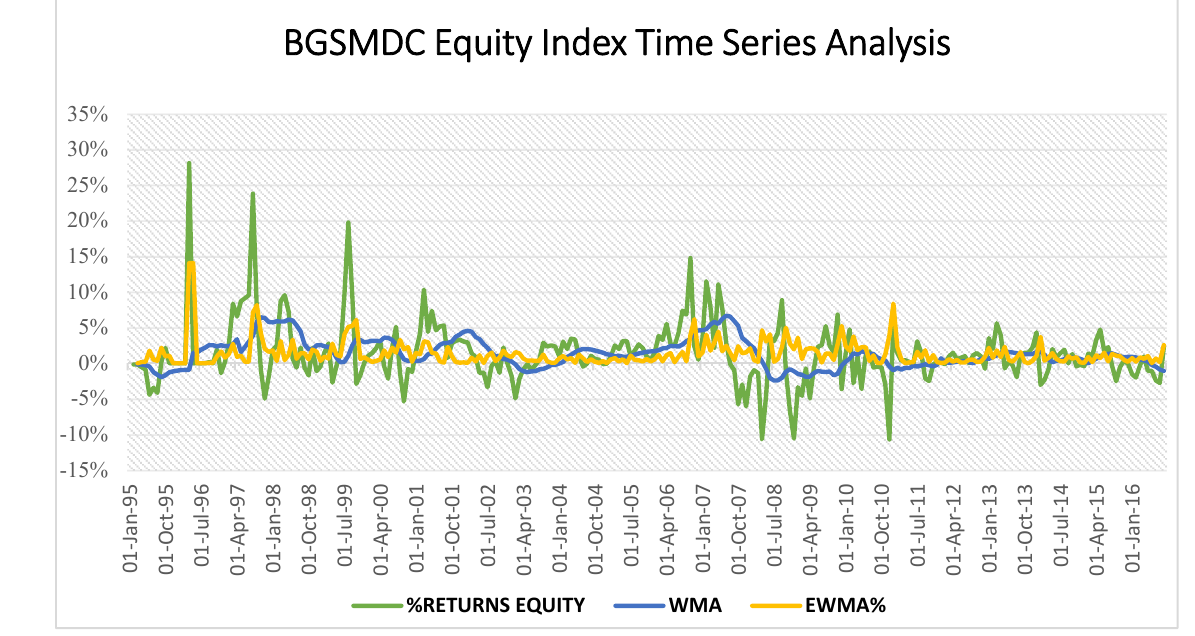
Figure 8. BGSMDC monthly time series analysis, equity. Source: authors. Figure 9 reveals that the HFRI hedge fund has a unique characteristic, which is structured in a way so that it has many fund managers and so that it tends to be more diversified, and so volatility is around the mean and relatively stable. Clustering and huge sparks are shown in the crisis periods for the returns line.